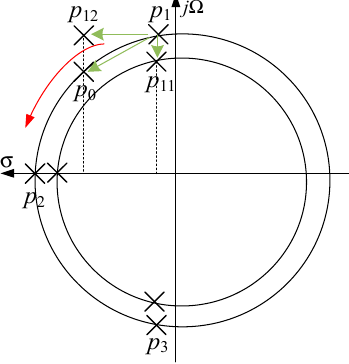
Figure 7. Zero-pole distribution and offset analysis of the FRF.